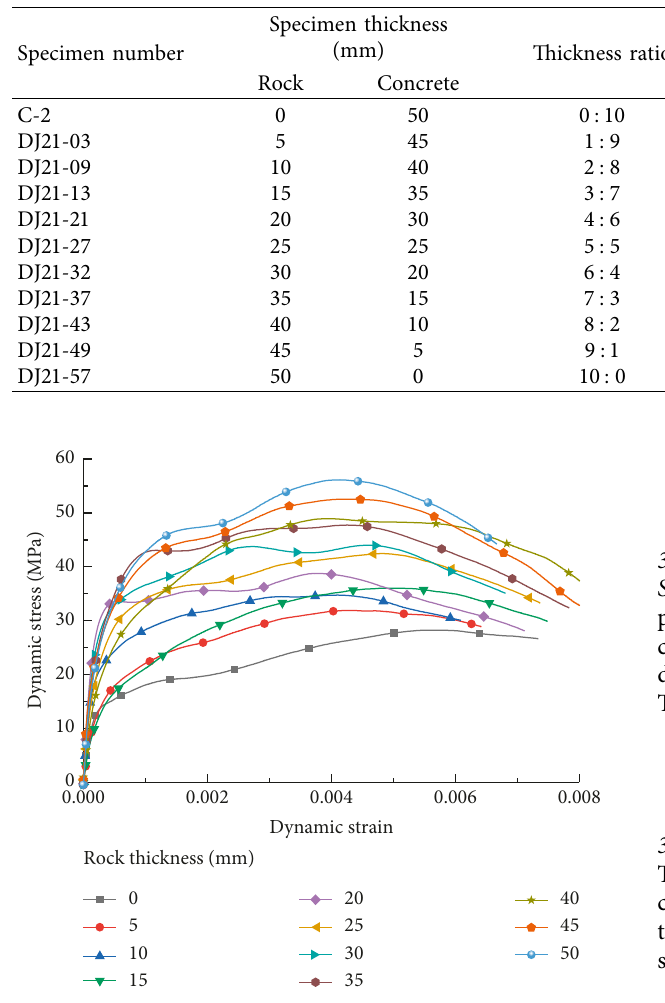
Figure 4: Dynamic stress-strain curves of rock-concrete combined